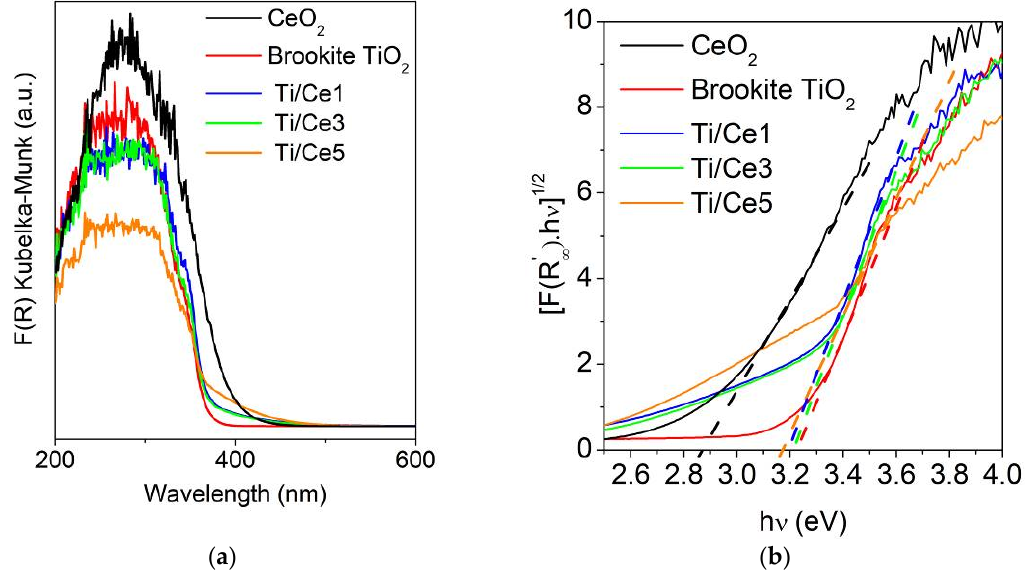
Figure 4. ( a ) Kubelka-Munk function (reflectance function) versus the wavelength and ( b ) the modified Kubelka-Munk function versus the h ν for the investigated samples.